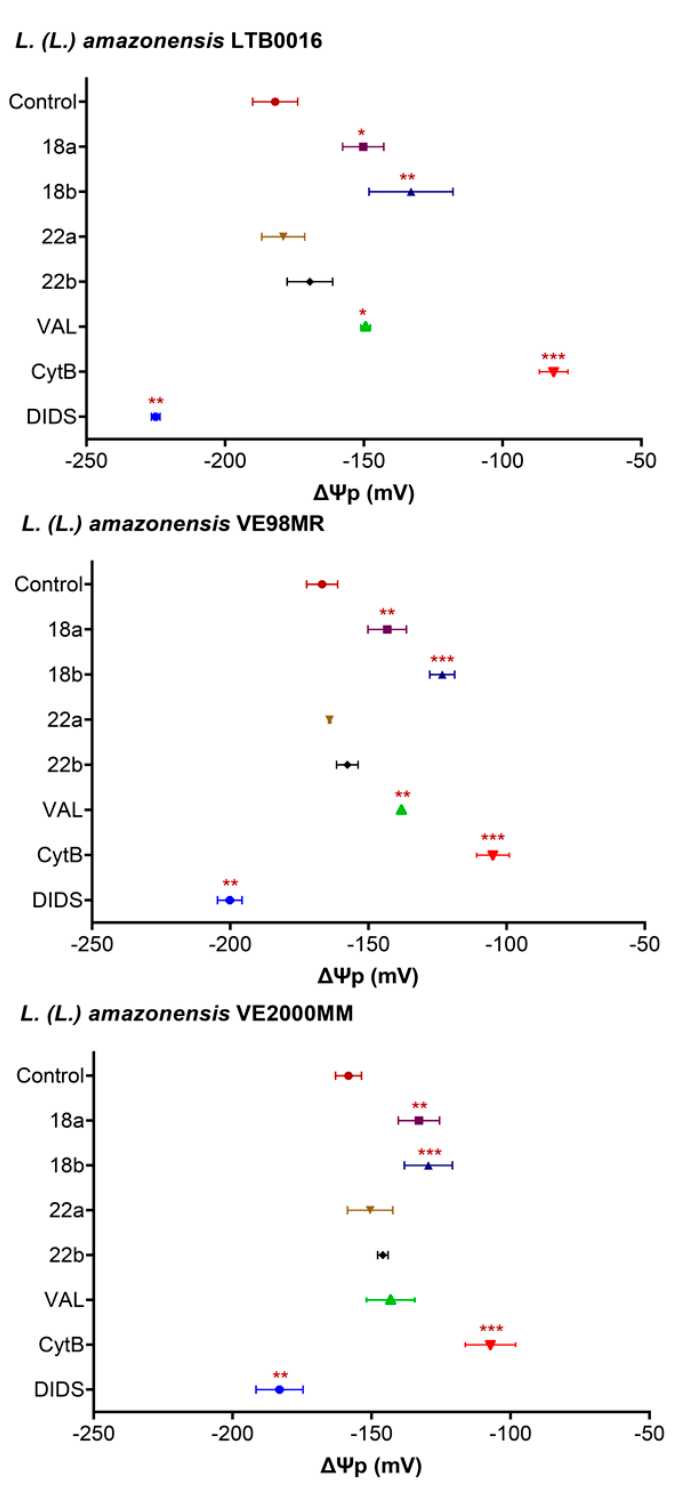
Figure 1. Effect of betulin derivatives on plasma membrane potential ( ΔΨ p) in L. (L.) amazonensis reference strain LTB0016 and isolates VE98MR and VE2000MM promastigotes isolated from patients, at two increasing concentrations (a and b): 18 (1 and 2 µM), 22 (2 and 4 µM), incubated for 15 min. Each bar or point represents the average ( n = 3 to 6 independent experiments) with its standard error (SEM). * p < 0.05; ** p < 0.005; *** p < 0.0005 compared to control without treatment. Control: without treatment; VAL: valinomycin, 1 µM; CytB: cytochalasin B, 300 µM; DIDS: sodium 4,4’-diisothiocyano- 2,2’-stilbenedisulfonate, 500 µM.